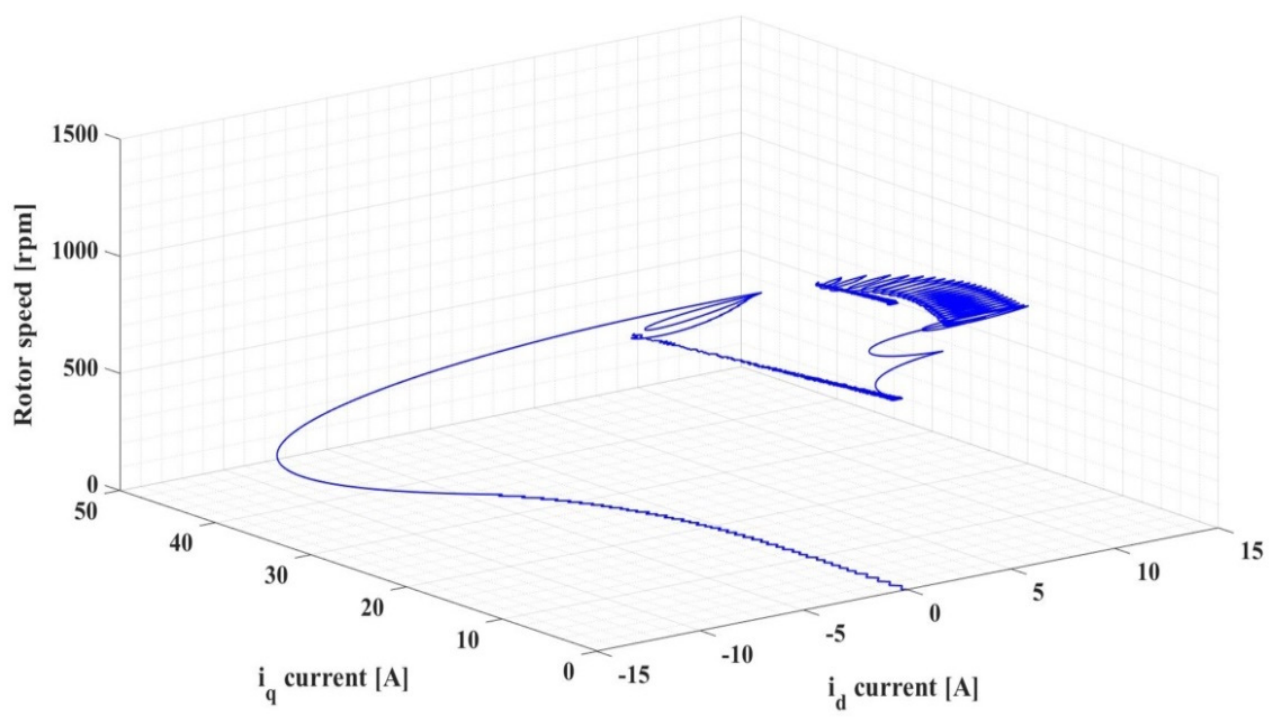
speed versus i q current versus i d current ( ω ref = 800 rpm).